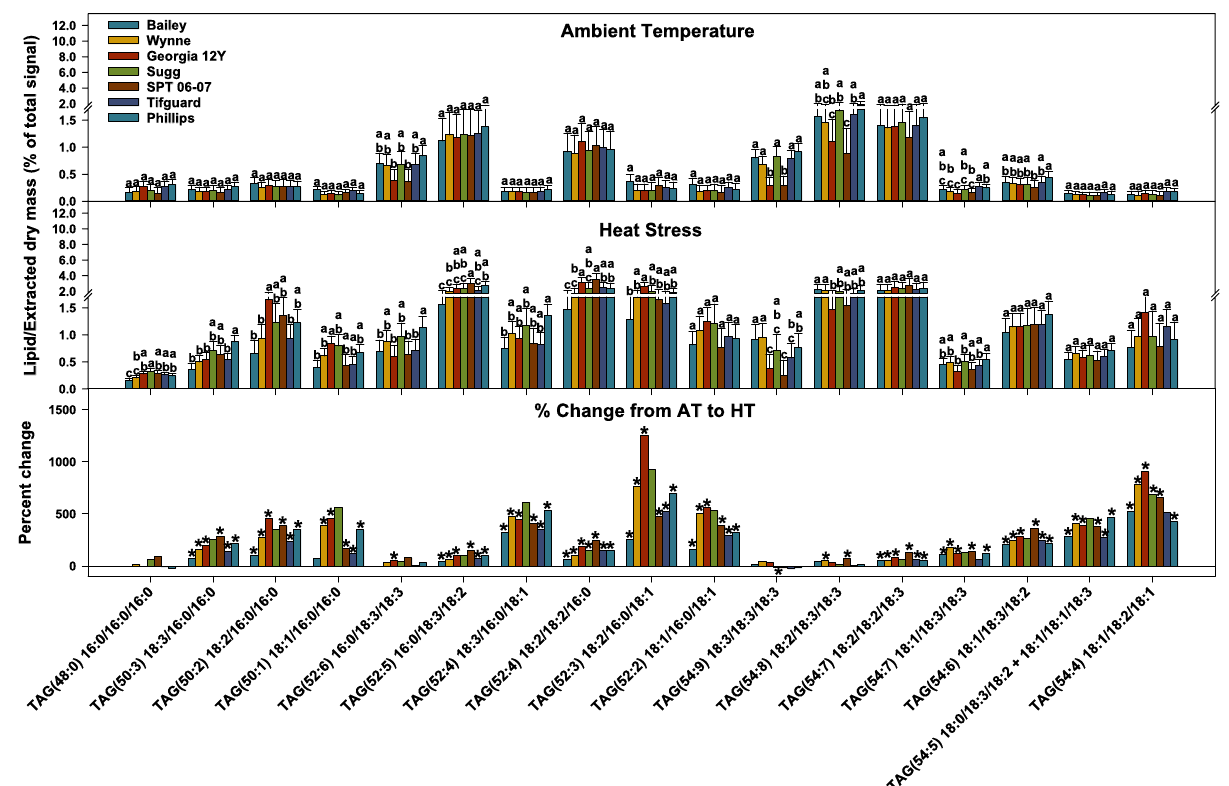
Figure 5. Changes in the percentage of total signal of triacylglycerol (TAG) molecular species in peanut anthers in response to heat stress. Lipid species shown were those that passed both the limit of detection (LOD > 0.0005 nmol) and coefficient of variation (CoV < 0.3) cutoffs (see “Materials and methods” for more details). Values shown are least-squares means. Error bars represent standard errors about the least-squares mean of 16 observations (2 years × 2 blocks × 4 replications) except for Sugg and SPT 06-07, which have 8 observations (1 year × 2 blocks × 4 replications). Least-squares means with different letters are significantly different according to Fisher’s least significant difference (LSD) test at α = 0.05. An asterisk (*) above bars indicate a significant difference at α = 0.05 between AT and HT for that genotype. AT, ambient temperature (31/22 °C for 2018 and 28/22 °C for 2019; average day/night temperatures during the 17-days and 18-days treatment periods in 2018 and 2019, respectively); HT, high temperature (41/27 °C for 2018 and 38/26 °C for 2019). Lipid molecular species are identified as total acyl carbons: total double bonds. Acyl-chain composition is included after each TAG lipid species but does not indicate sn positions. Breaks on the y axis indicate a change in scale. Data from 2 years (2018 and 2019) were pooled together for